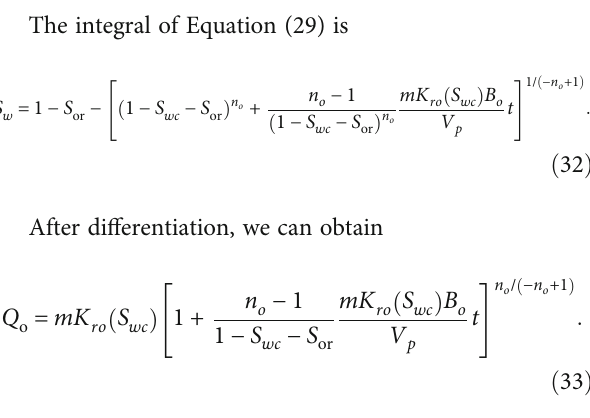
The stress sensitivity coefficient is 0.005 The stress sensitivity coefficient is 0.05 The stress sensitivity coefficient is 0.1 Figure 14: Schematic diagram showing the e ff ect of di ff erent stress sensitivity coe ffi cients on the